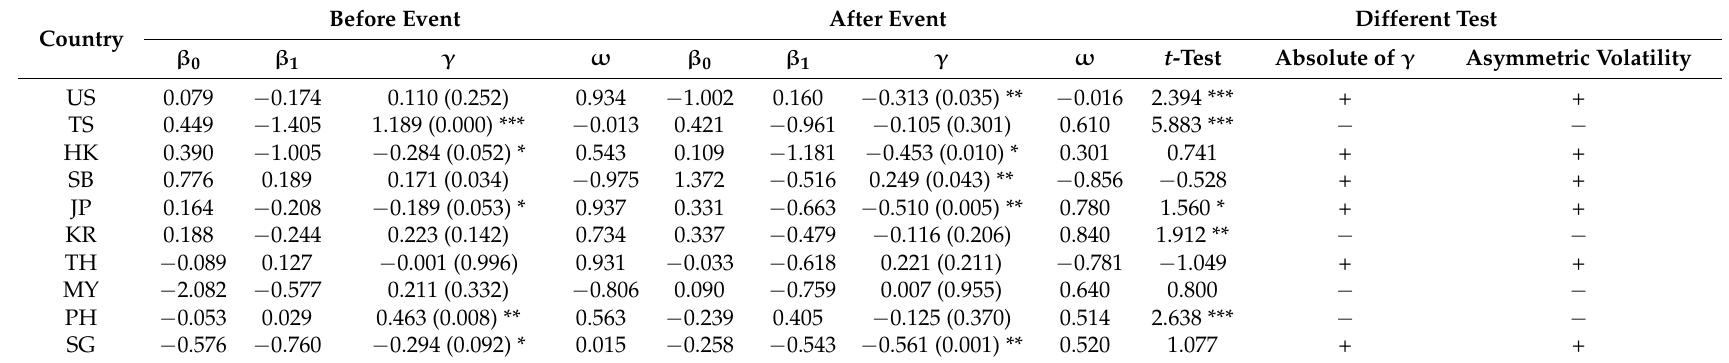
Table 15. The EGARCH model results: South Asian